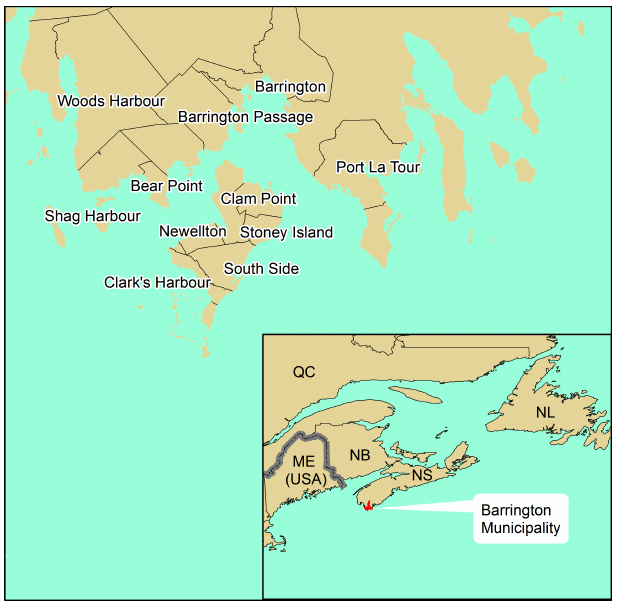
Fig. 1 . Map of study area, including names of active fishing